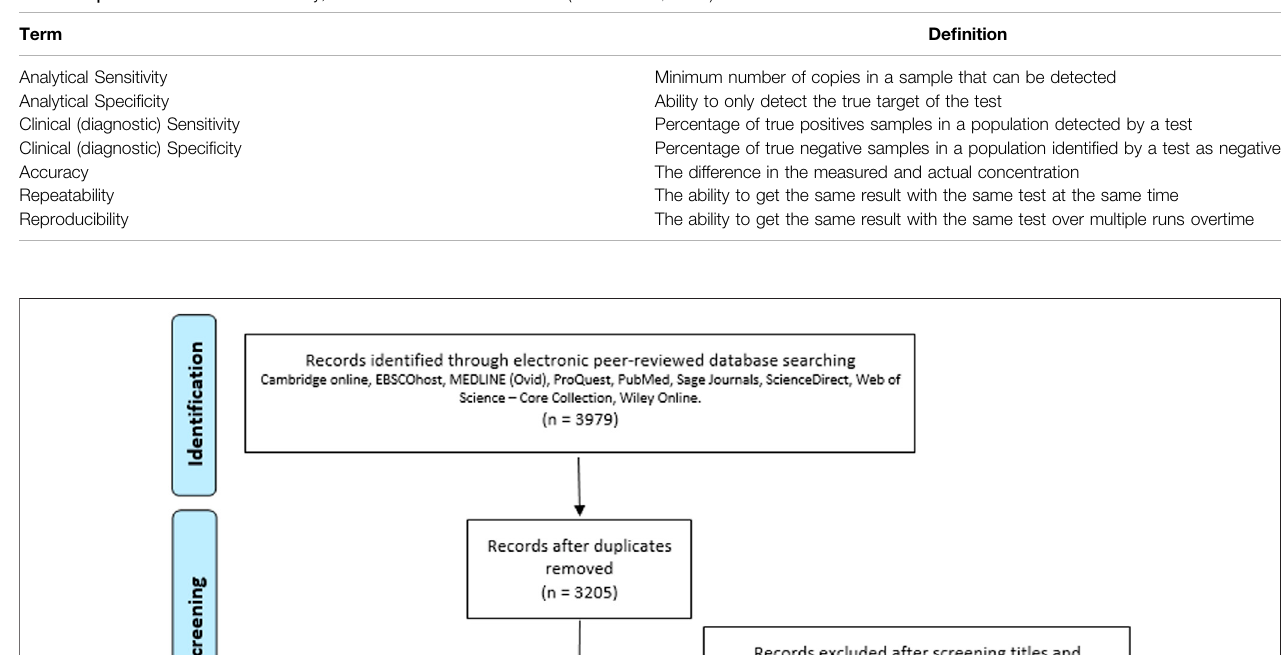
Frontiers in Molecular Biosciences |